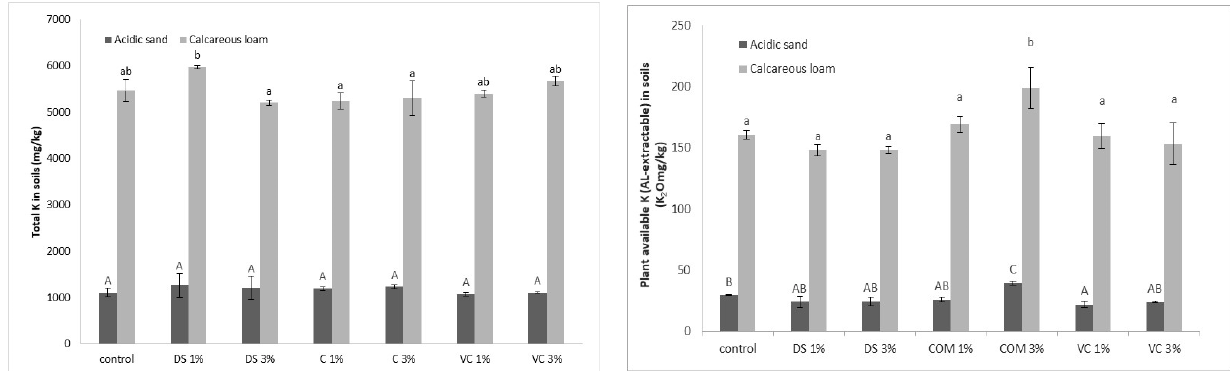
Figure 4. Changes in the concentration of total and plant-available K in the soil 75 days after the application of digested sludge (DS), digested sludge compost (COM), and digested sludge vermicompost (VC) in 1% and 3% doses. Error bars represent the standard deviation (SD) of the mean with 3 replicates. Uppercase letters indicate significant differences between treatments on acidic sand and lowercase letters indicate significant differences between treatments on calcareous loam ( p < 0.05).